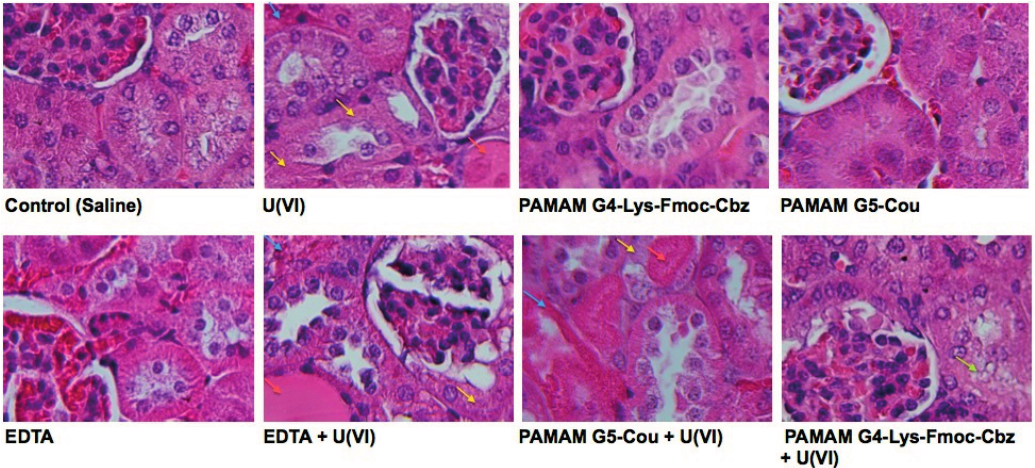
Figure 6. Histological cut of the kidney obtained from the different experimental groups. Yellow arrows: necrosis; blue arrows: eosinophilia; red arrows: thyroidization; green arrows: vesiculation